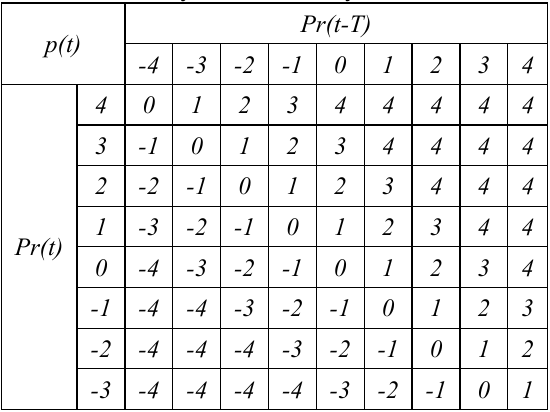
Table 6. Index systems of fuzzy rules for